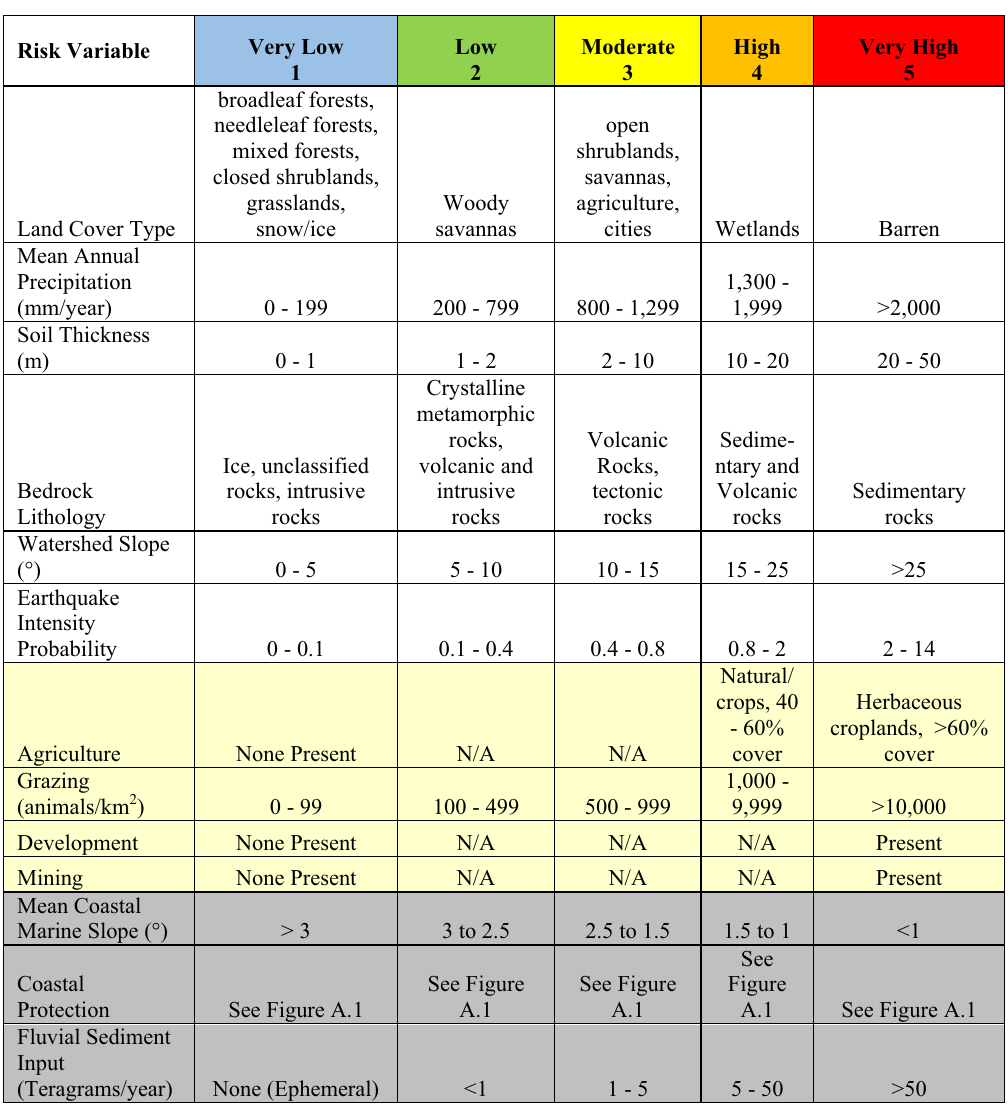
Table 1. The ten variables used in Erosion Vulnerability Index (EVI) analysis (white and pale yellow cells) and the 3 Erosion and Deposition Vulnerability Index (EDVI) variables (gray cells) and their Risk Factor ranges. Datasets values listed above are converted to Risk Factors of Very Low to Very High or numerically 1–5. Variables highlighted in pale yellow were combined into one Risk Factor for analysis (AGMD), hence the 7 Risk Factors ultimately used in the EVI. Variables highlighted in gray were added when calculating the EDVI analysis, each represent 1/6 of the total EDVI grid cells. See Supplemental Fig. S1 for Coastal Protection Risk Factor details and Supplemental Table S1 for data